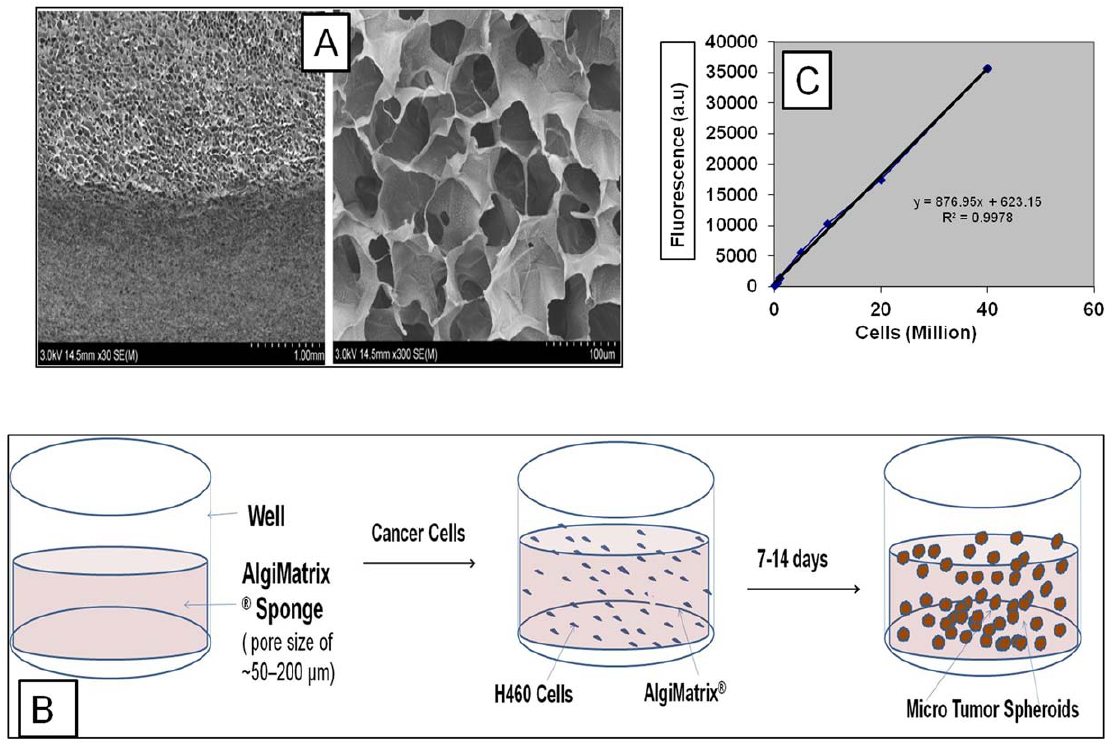
Figure 1. Algimatrix 3D culture system. Scanning Electron Microscopic (SEM) images of 3D alginate scaffolds at lower resolution (left panel, 30 K) and higher resolution (right panel, 300 K), figure shows pore sizes in the matrix to accumulate the cells and grow them as spheroids (A). B) The schematic representation of 3D alginate scaffold wells and how spheroids are formed and grown in the 3D alginate scaffold cell culture system upon seeding the cells into the porous alginate media, C) Standard curve for H460 cells in AlamarBlue assay. Cells at different densities were incubated with AlamarBlue dye, after optimum incubation time point (4 h) fluorescence was measured at 530 and 570 excitation and emission, respectively.